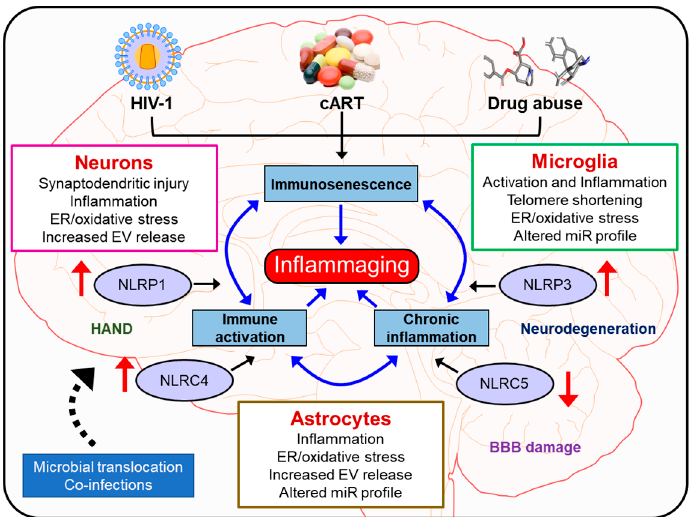
Figure 4. HIV-1/HIV-1 proteins, cART, and/or drug abuse induce inflammasome proteins via oxidative stress, altered miR expression, and EVs, thereby triggering glial activation, leading to secretion of proinflammatory cytokines resulting in synaptodendritic injury and neuroinflammation and ultimately neuroinflammaging.